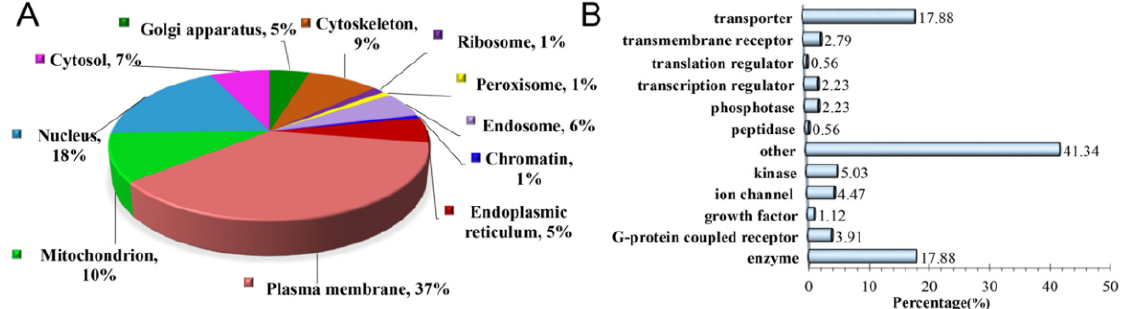
Figure 2. Subcellular localization and biological relevance of significantly altered MAM proteins in Type 1 diabetic rat retinas identified by proteomics. ( A ) Organelle association of the 179 altered MAM proteins based on cross-referenced annotation. ( B ) Percentages of molecule types, according to GO analysis from available database information. MAM: Mitochondria-associated ER membrane, GO: Gene ontology.